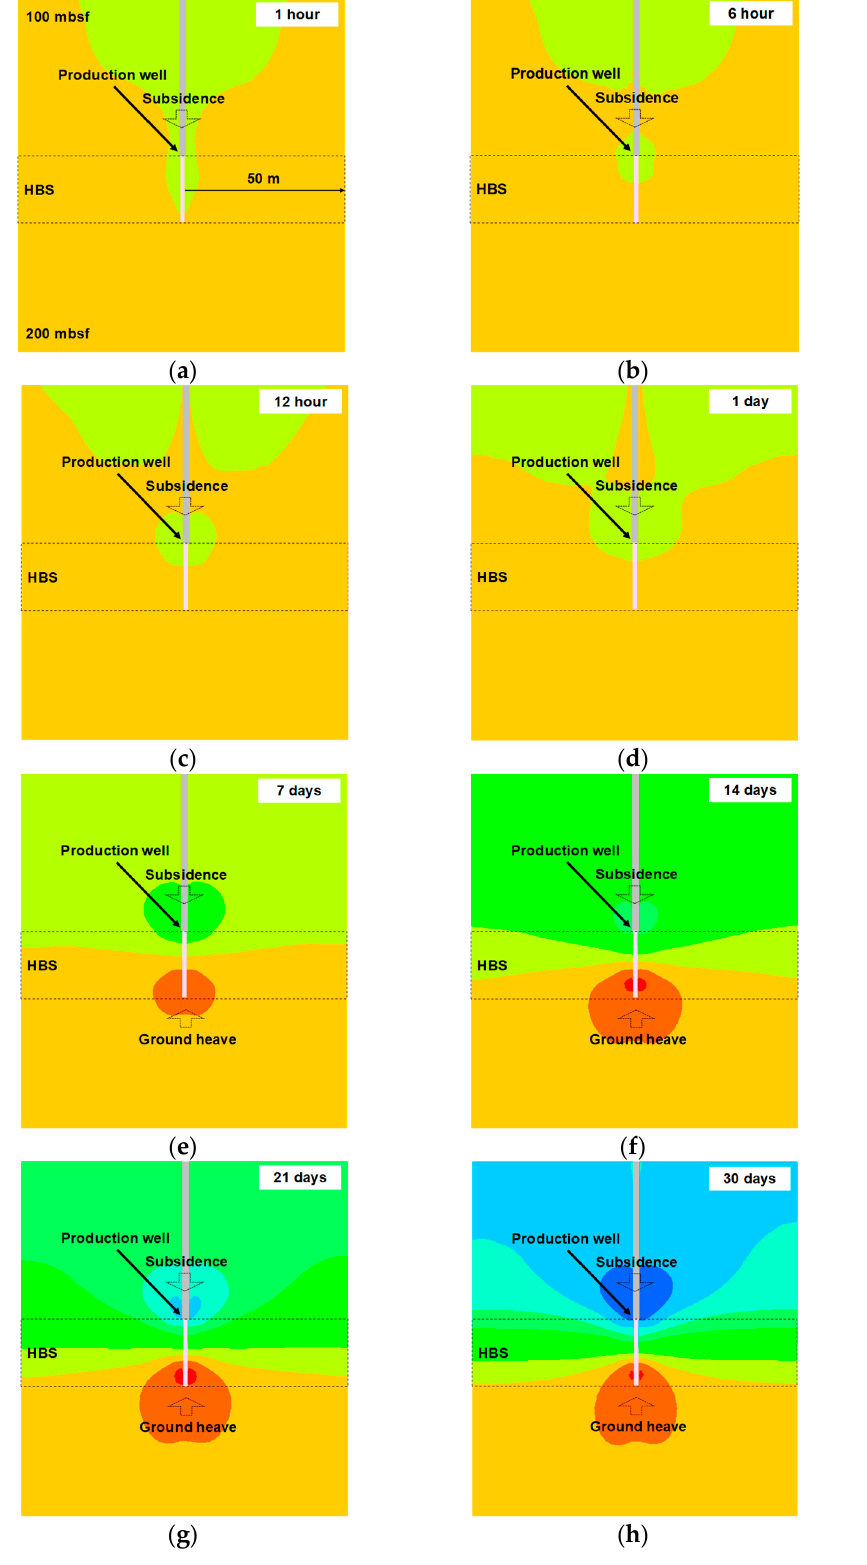
Figure 10. Distribution of z-axis displacement with production period: ( a ) after 1 hour; ( b ) after 6 hours; ( c ) after 12 hours; ( d ) after 1 day; ( e ) after 7 days; ( f ) after 14 days; ( g ) after 21 days; ( h ) after 30 days.